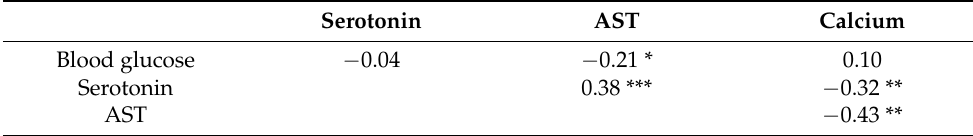
Table 2. Correlation coefficients between the serum biochemical parameters of broilers. Serotonin AST Calcium Blood glucose − 0.04 − 0.21 * 0.10 Serotonin